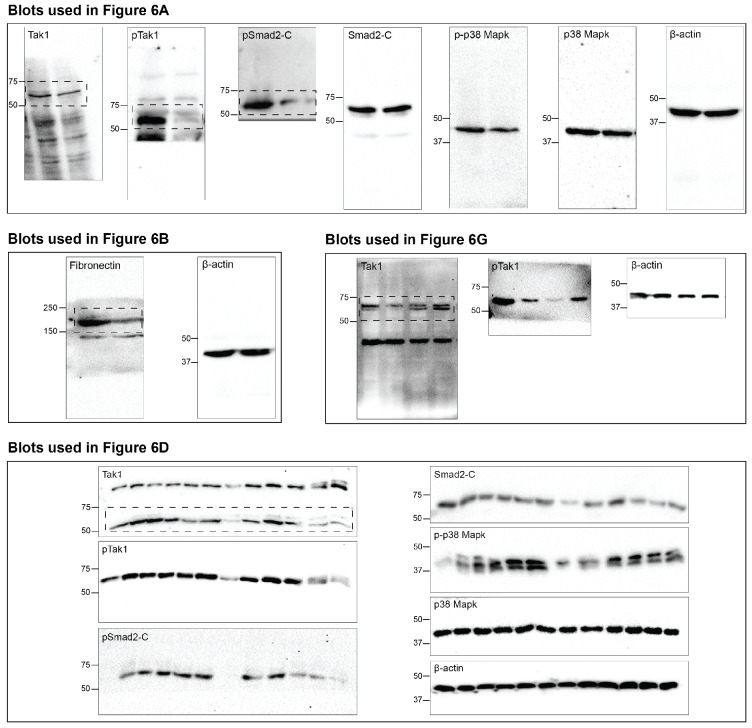
Impaired Rbfox2-TGFβ-Tak1 signaling axis due to Rbfox2 deletion.Uncropped western blot images presented in Figure 6 of this manuscript. Dotted box indicates areas that were cropped for use in figures when multiple bands observed.